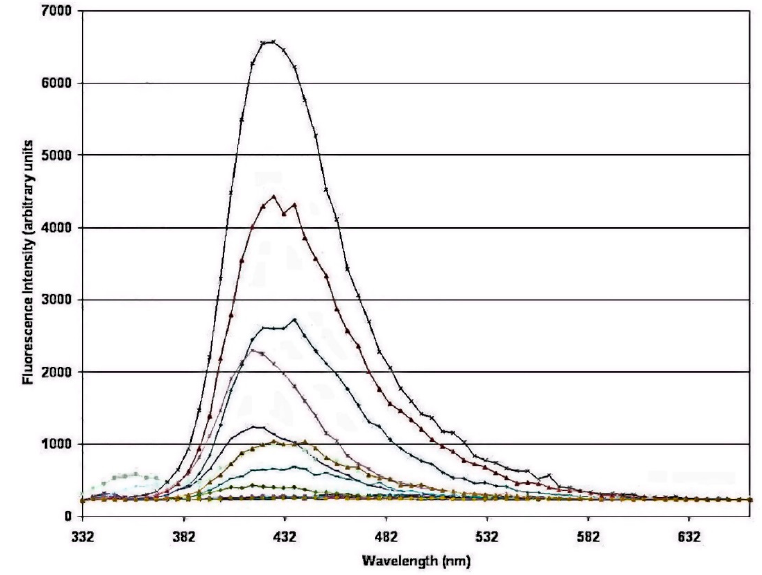
Figure 5. Fluorescence spectra of several light crude oils after activation with a 308 nm laser (Environment Canada). Spectra were obtained in a laboratory.